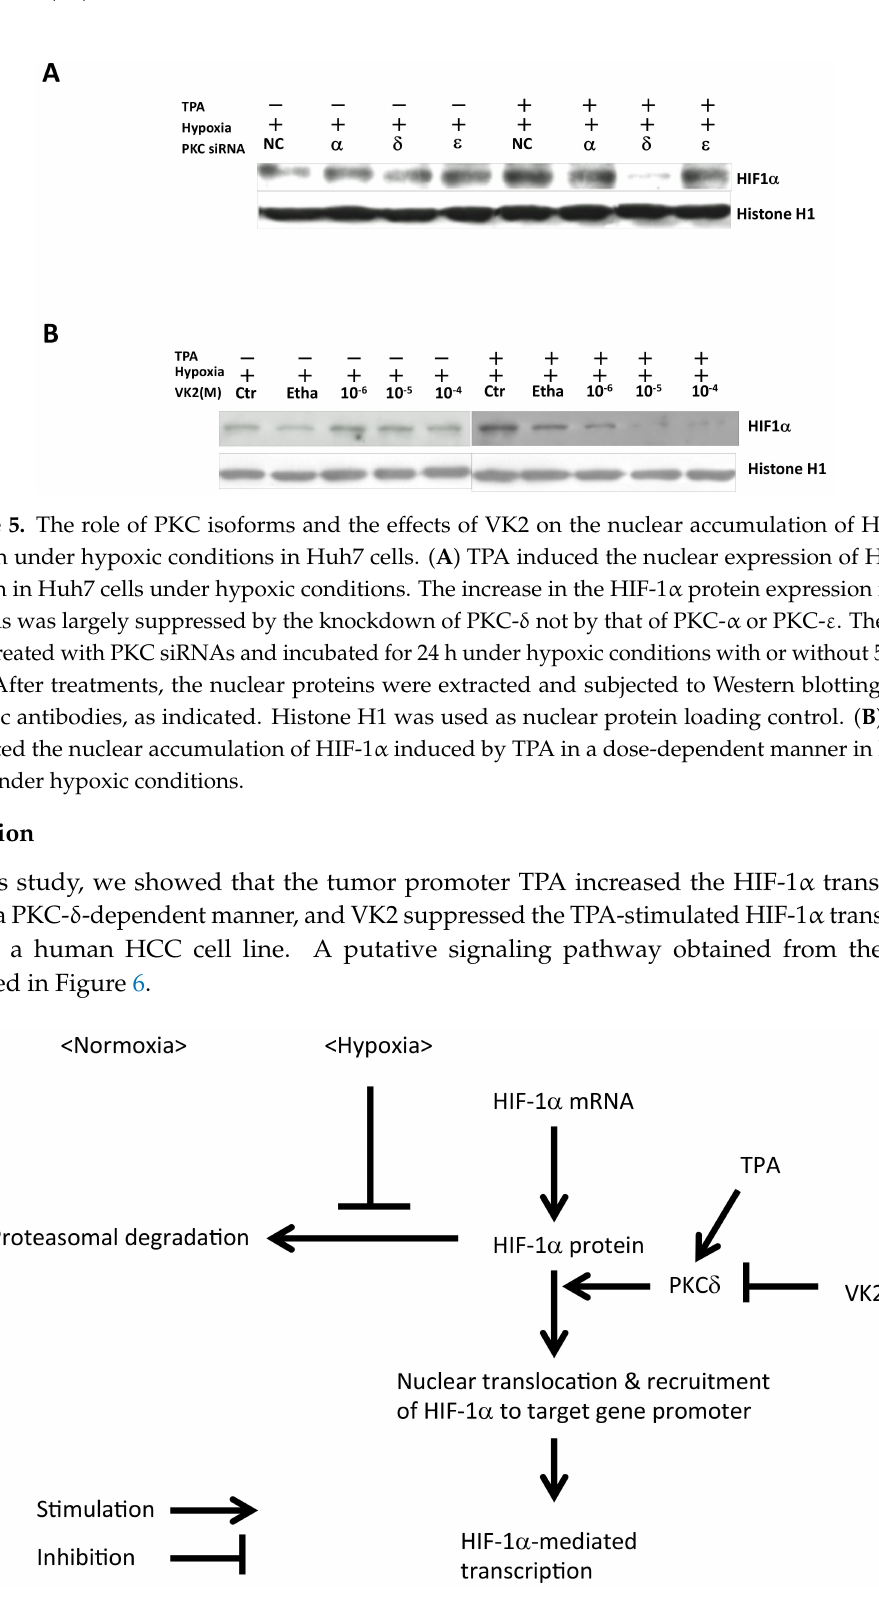
Figure 6. A proposed signaling pathway that regulate HIF-1 α transcription activity through PKC- δ isoform and